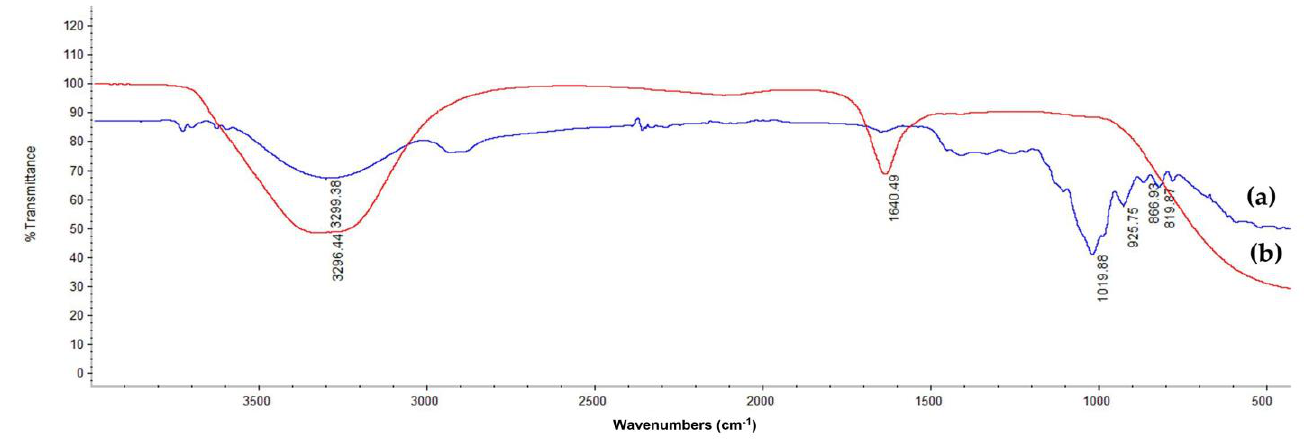
Figure 8. The FTIR spectrum of mixture prebiotics: ( a ) before being incubated with probiotics;